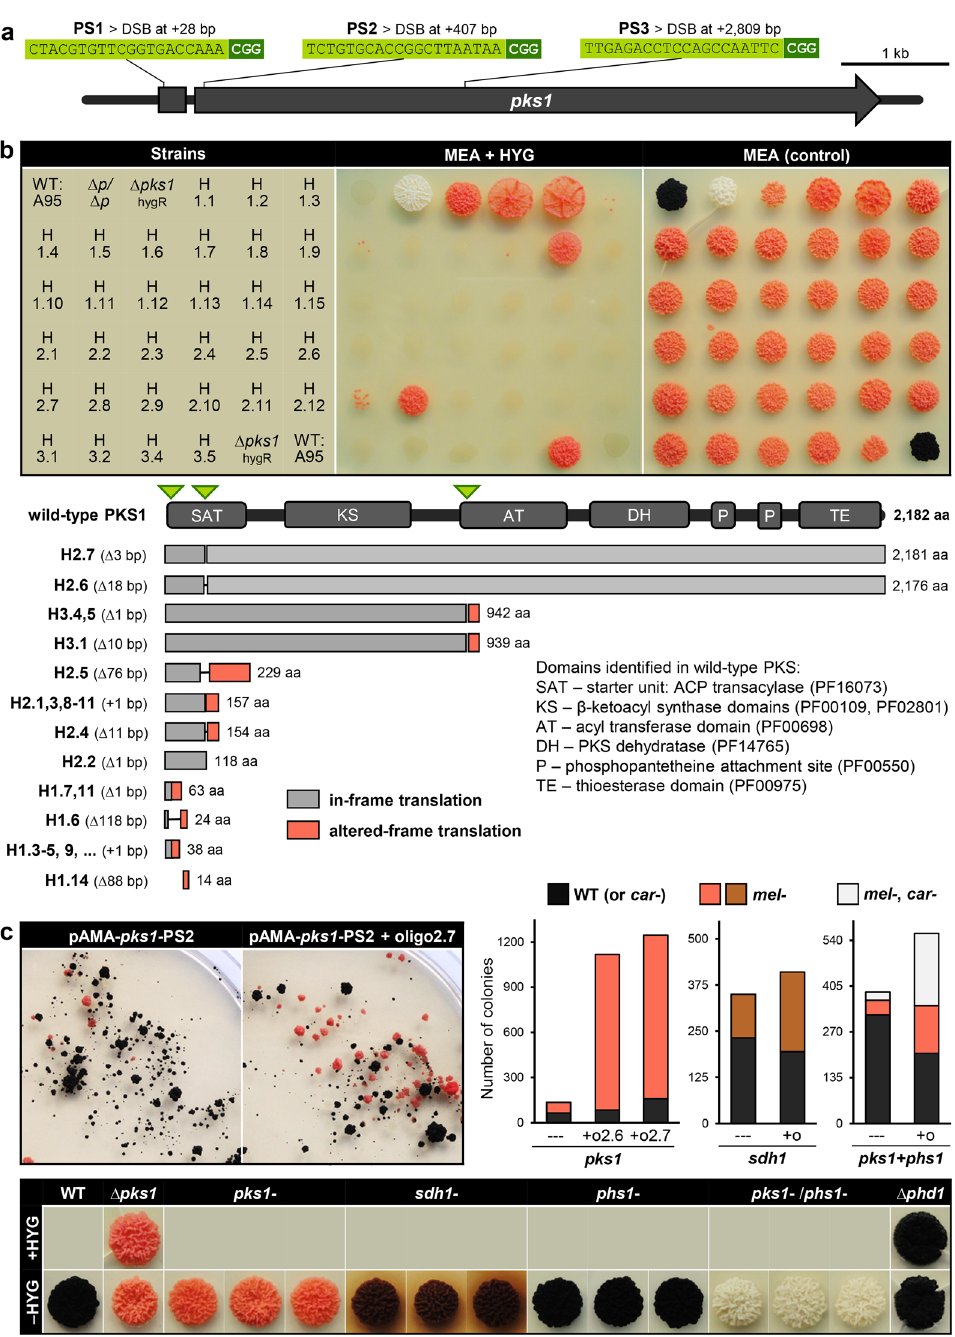
Figure 4. Generation of marker-free mutants with the CRISPR/Cas9 technique. ( a ) Strategies for CRISPR/Cas9-assisted inactivation of pks1 . Three protospacers (PS) for inducing DSBs in different regions of pks1 were combined with the sgRNA backbone, cas9 , a hygR cassette as well as the AMA1 sequence (Table S1). PS- and PS-adjacent motifs (PAM) are shown. ( b ) Random mutation of pks1 via non-homologous end joining (NHEJ). WT:A95 protoplasts were transformed with the circular cas9/pks1 -sgRNA-containing AMA plasmids (Table S3). 31 mel− mutants were studied. MEA was inoculated with cell suspensions and incubated for 11 days. ∆ p/ ∆ p − ∆ pks1/∆phd1 . Sequencing of PS-spanning regions revealed point mutations and short deletions at the Cas9 sites (green triangles) resulting in truncated proteins. Mutants H2.7 and H2.6 contain in-frame deletions (Fig. S5). ( c ) Increase of editing efficiency by addition of single-stranded DNA oligonucleotides. WT:A95 protoplasts were co-transformed with cas9 -sgRNA-containing AMA plasmids and single-stranded 80-bp-long DNA oligonucleotides (+ O) that covered the Cas9 cutting sites and comprised mutations (Fig. S6). Numbers of differentially pigmented colonies on the transformation plates were quantified from four independent experiments (Table S6). Representative plates for pks1 are shown on the left. The PS-spanning regions of chosen mutants were amplified by PCR and sequenced to detect the mutations at the Cas9 cutting sites (Fig. S6). MEA was inoculated with cell suspensions and incubated for 8